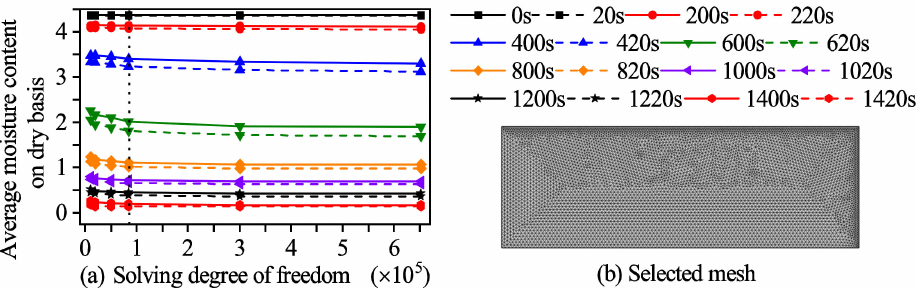
Figure 3. Grid independency analysis. ( a ) Average moisture content evolution with solving degrees of freedom at different time points. ( b ) The selected mesh size in this study.